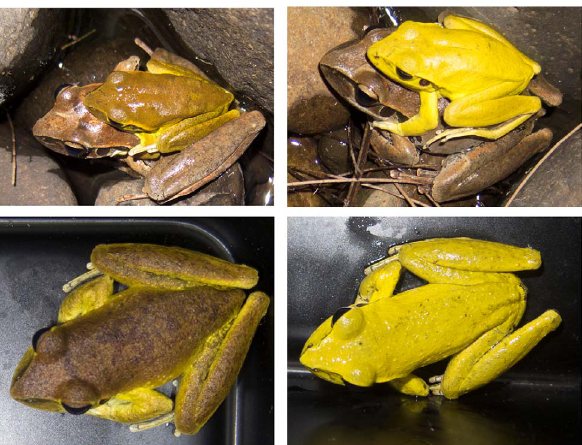
Figure 1. Male L. wilcoxii during amplexus at time 0 (top left), after 10 minutes (top right), baseline pre- amplectic male (bottom left), and post epinephrine injection (bottom right). Colour score for the brown male is 2 1.93 (RGB 5 67, 58, 30) and the amplexing male is 3.01(RGB 5 254, 249,